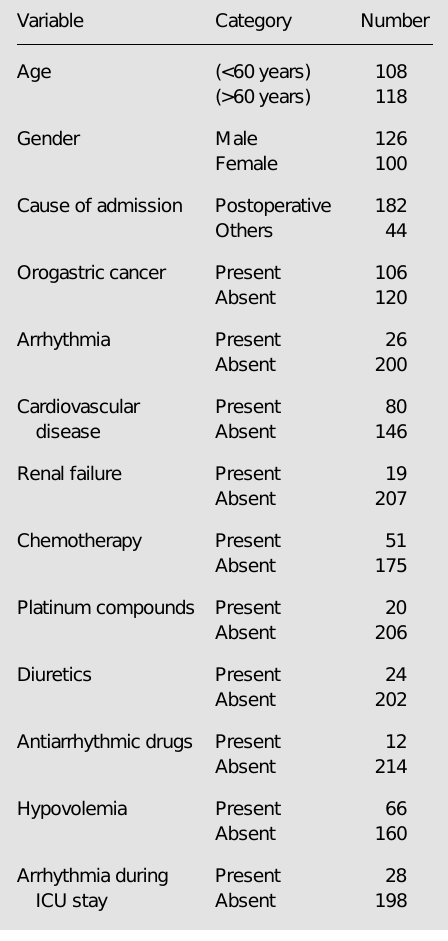
Table 1 - Population characteristics before admis- sion and during permanence in the ICU.